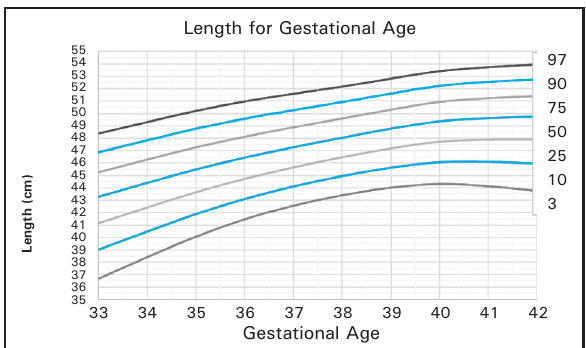
Figure 3. Smoothed curve for crown-heel length.